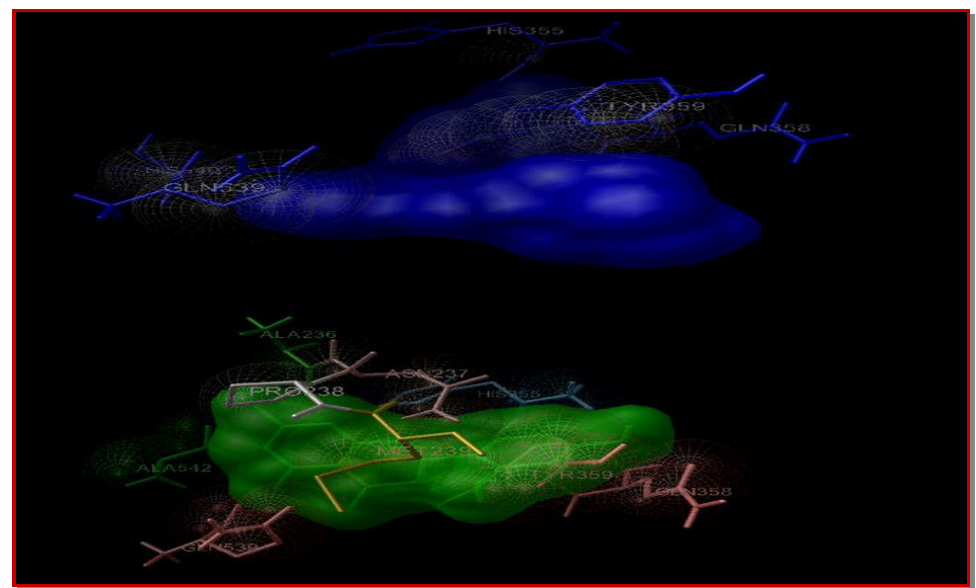
Figure 3: Docked pose of lipoxygenase enzyme (3D3L) with azelastin and